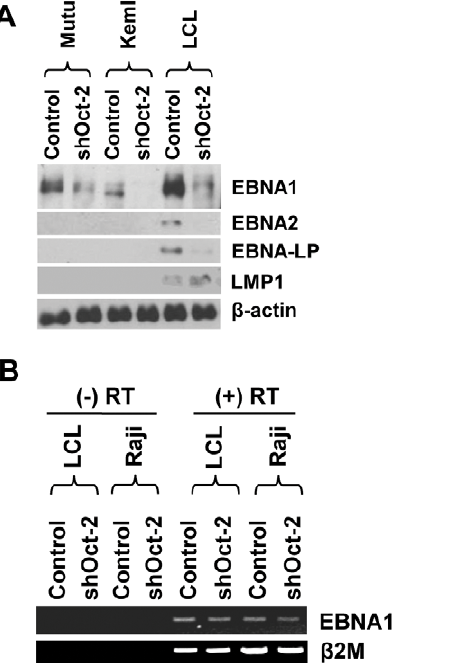
Figure 10. Oct-2 knockdown decreases EBNA1 protein expres- sion in cells with type I and type III latency. (A) Type I BL cell lines, MutuI and KemI, and the type III lymphoblastoid cell line (LCL) were infected with a pool of five different lentivirus vectors directed against Oct-2, or control shRNAs. The cells were selected for 7 days using puromycin. The expression levels of the latency proteins EBNA1, EBNA2, EBNA-LP, and LMP1 were examined using immunoblot analysis. b -actin expression was used as a loading control. (B) The level of the EBNA1 transcript was examined by RT-PCR in type III LCL and Raji cells which were infected with a pool of five different lentivirus vectors directed against Oct-2, or control shRNAs. The cells were selected for 7 days using puromycin prior to RT-PCR analysis. The b 2 -microglobulin gene was used as a control.